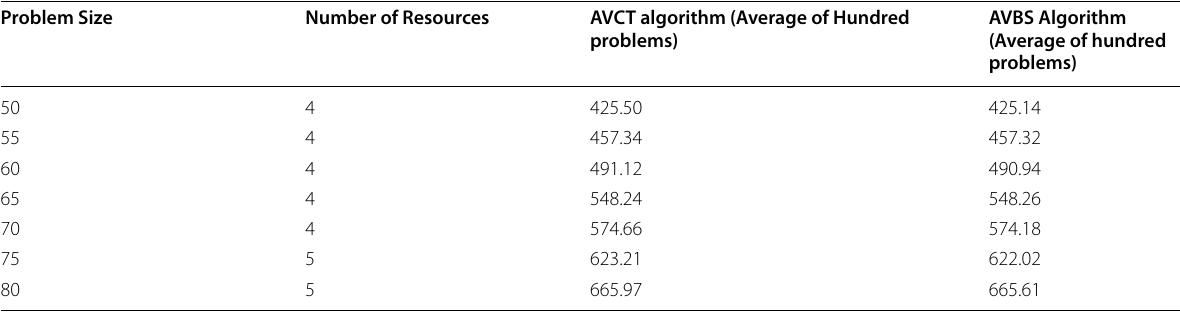
Table 3 Comparison of the AVCT and AVBS algorithms Problem